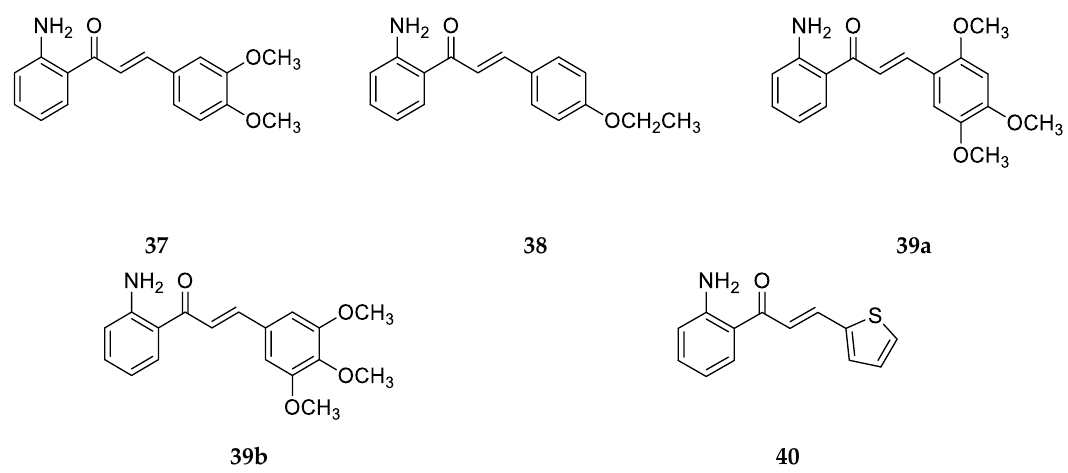
Figure 26. Chemical structures of derivatives of 2-aminochalcone with substitution on ring B. Aminochalcone 37 was tested for antifungal activity against Trichophyton rubrum , and its minimum inhibitory concentration needed to inhibit 80% of cells (MIC 80 ) was determined to be greater than 64 µg/mL, which was higher than most of the chalcones tested and overall demonstrated that 37 was not a good antifungal agent [55].